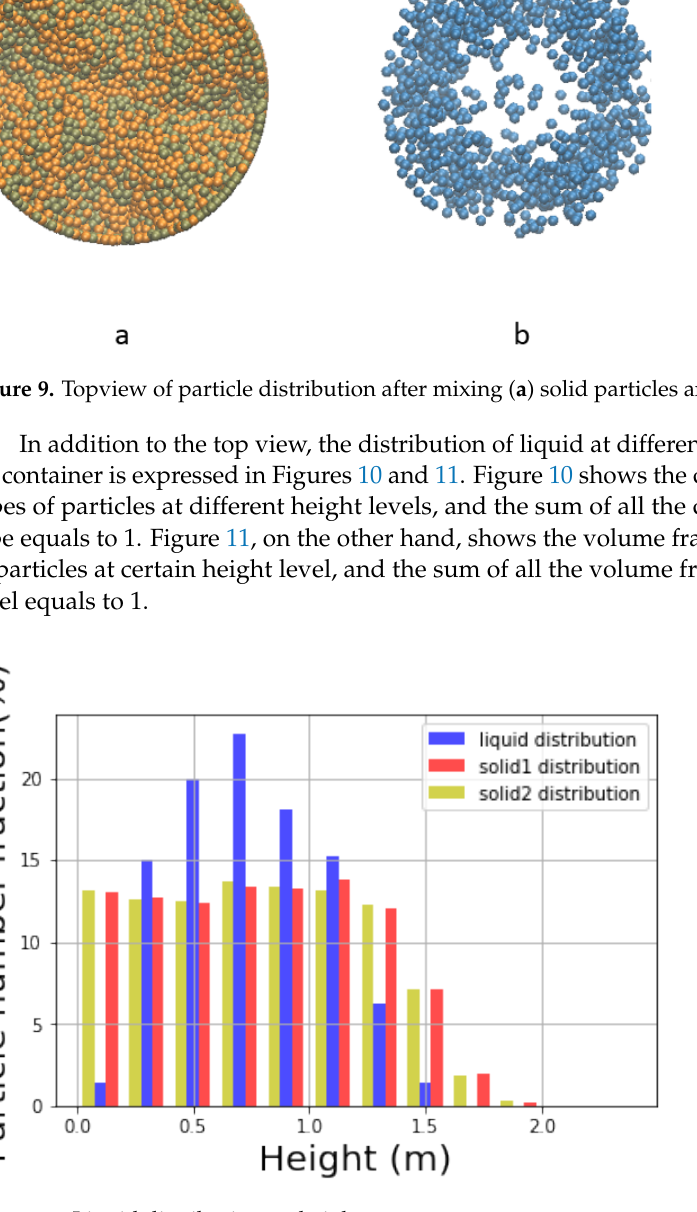
Figure 10. Liquid distribution on